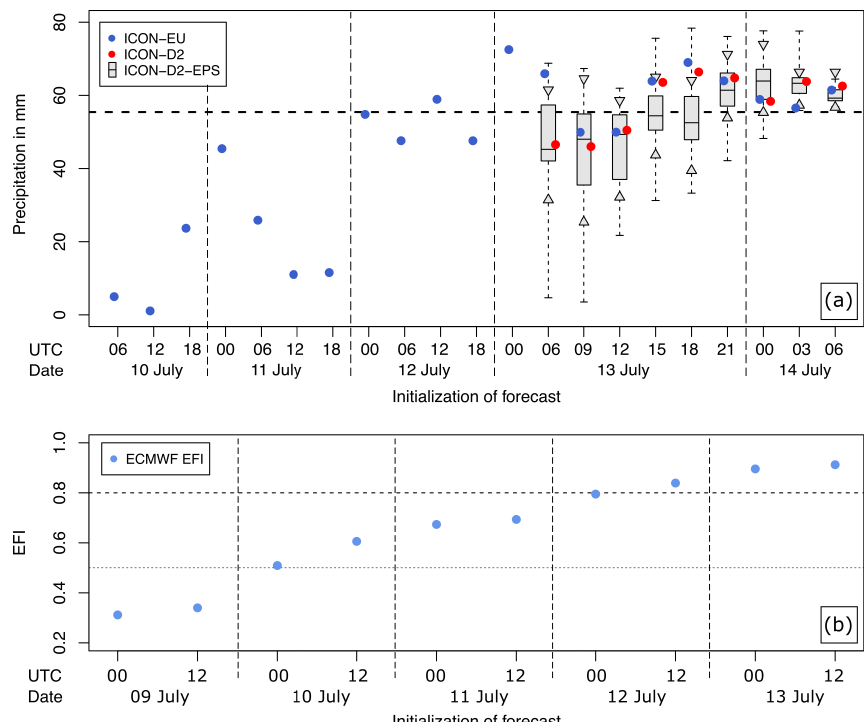
Figure 4. (a) 24h precipitation totals over LReg (14 July 06:00UTC to 15 July 2021 06:00UTC) as forecasted by ICON-EU, ICON-D2, and ICON-D2-EPS for different initialization times and observed precipitation total as reference based on RADOLAN: 55.4mm (stippled black horizontal line). For the EPS, the boxes represent the median and 25% or 75% percentiles, the triangles the 10% or 90% percentiles and the whiskers the total ensemble range. (b) Extreme forecast index (EFI) for precipitation on 14 July 2021 based on the ECMWF-EPS for different initialization times. Horizontal lines at 0.5 and 0.8 denote the limits for classification of an unusual (EFI between 0.5 and 0.8) and very unusual or extreme event (EFI greater 0.8).